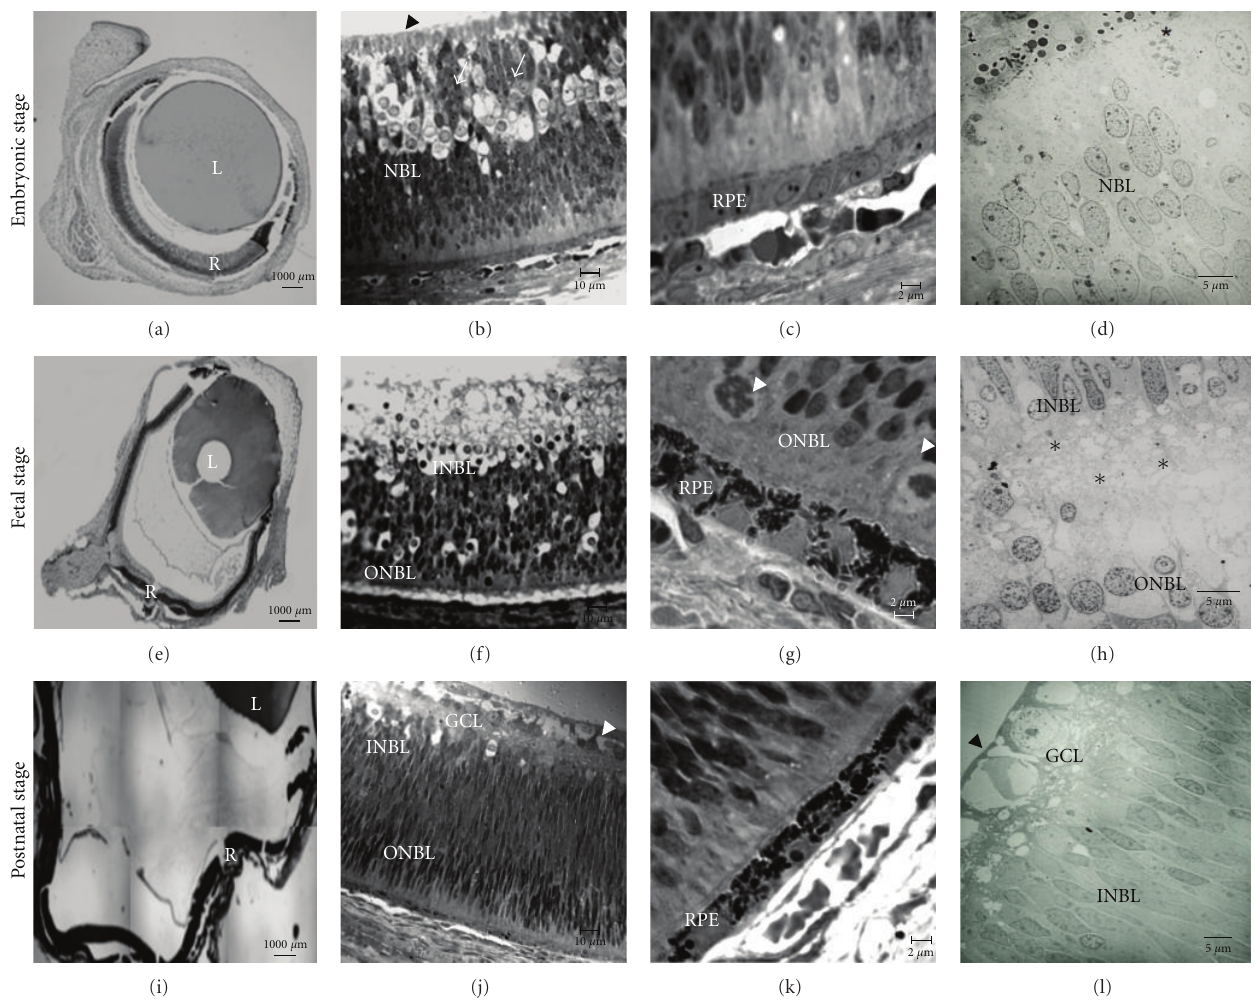
Figure 1: Histological analysis of the retina in embryos ((a)–(d)), fetuses ((e)–(h)) and neonatal ((i)–(l)) dogs. (a) Transversal section of the eye showing the retina (R) and lens (L). (b) In longitudinal section, retina consists of a neuroblastic layer (NBL) formed by an inner marginal (arrow head) and outer nuclear zone (arrows). (c) The retinal pigment epithelium (RPE) is observed to consist of a single layer with oval shaped melanosomes on the apical surface. (d) Electron micrograph showing cells with mitotic activity ( ∗ ) localized in the NBL. (e) Eye from the fetal stage where retina (R) and lens (L) are evident. (f) Cell migration has formed the inner neuroblastic layer (INBL) and outer neuroblastic layer (ONBL). (g) Some rudimentary photoreceptors were evident at the fetal stage (arrow head). (h) The INBL and ONBL are separated by the transitional space of Chievitz where high resolution exposes a space between the INBL and ONBL without any cells ( ∗ ). (i) Eye from the postnatal stage where part of the lens (L) and the retina (R) are visible. (j) During the postnatal stage the ganglion cell layer (GCL) was apparent. (k) The RPE was observed as a row of cubic cells. (l) Electron micrograph showing the GCL where the axons (arrow head) are forming the nerve